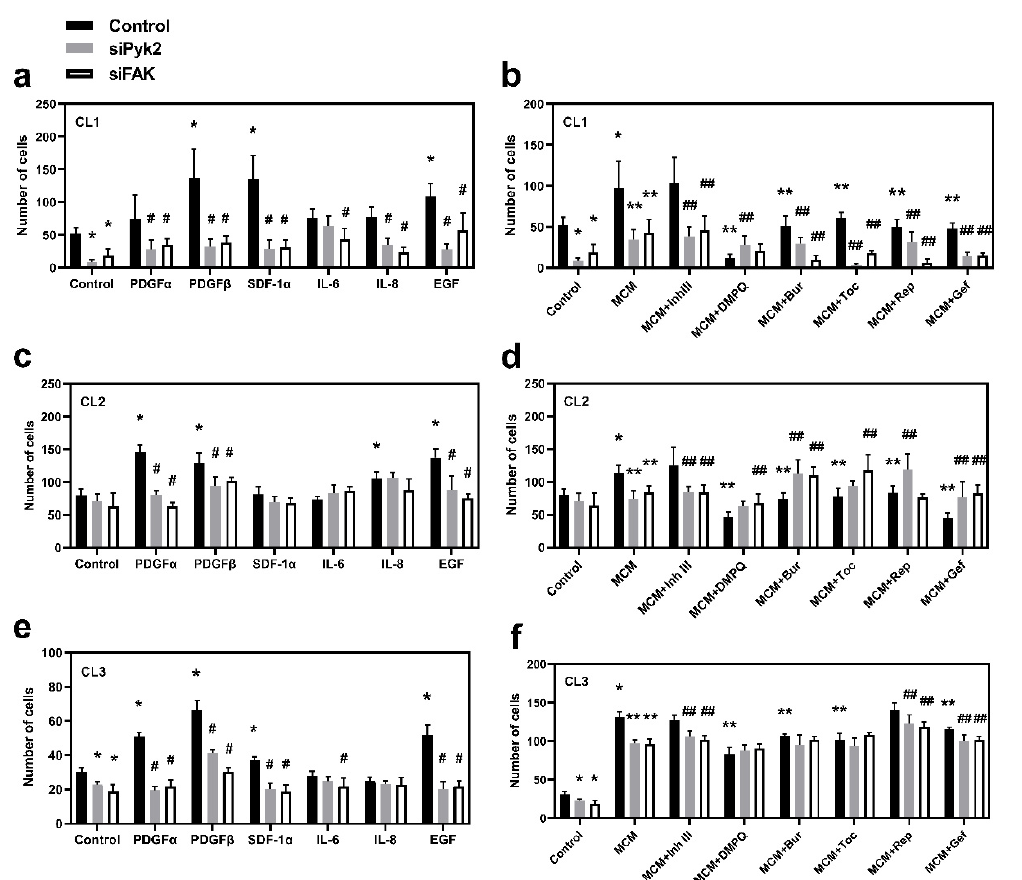
Figure 4. Cytokines released by microglia induce glioma cell migration through Pyk2 and FAK signaling. A Transwell invasion assay was performed to evaluate the migration activity of glioma cells. The number of migrated cells was calculated after treatments with cytokines in mock cells (control) and cells transfected with siRNA against Pyk2 or FAK, as well as cells treated with microglia-conditioned medium (MCM), with or without inhibitors in cell lines CL1 ( a , b ), CL2 ( c , d ), and CL3 ( e , f ). The values are shown as means ± SD for 3–6 experiments per group. * p < 0.05 vs. control, ** p < 0.05 vs. MCM, # p < 0.05 vs. the corresponding cytokine, ## p < 0.05 vs. the corresponding inhibitor. Inh III, inhibitor III; Bur, burixafor; Toc, tocilizumab; Rep, reparixin; and Gef,